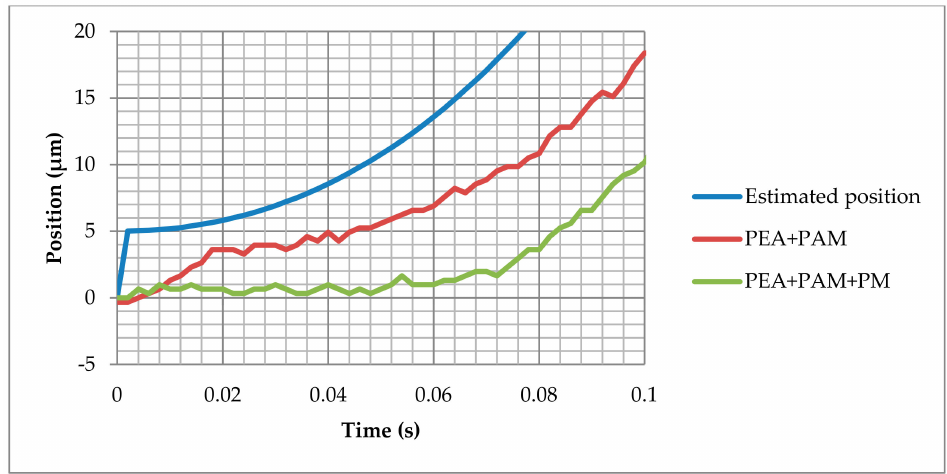
Figure 3. Open-loop system response comparison: Ideal system (Estimated position = Input Voltage × Displacement Constant), amplified piezoelectric actuator (piezoelectric actuator (PEA) + PEA amplifier mechanism (PAM)), and complete positioning system (PEA + PAM + positioning mechanism